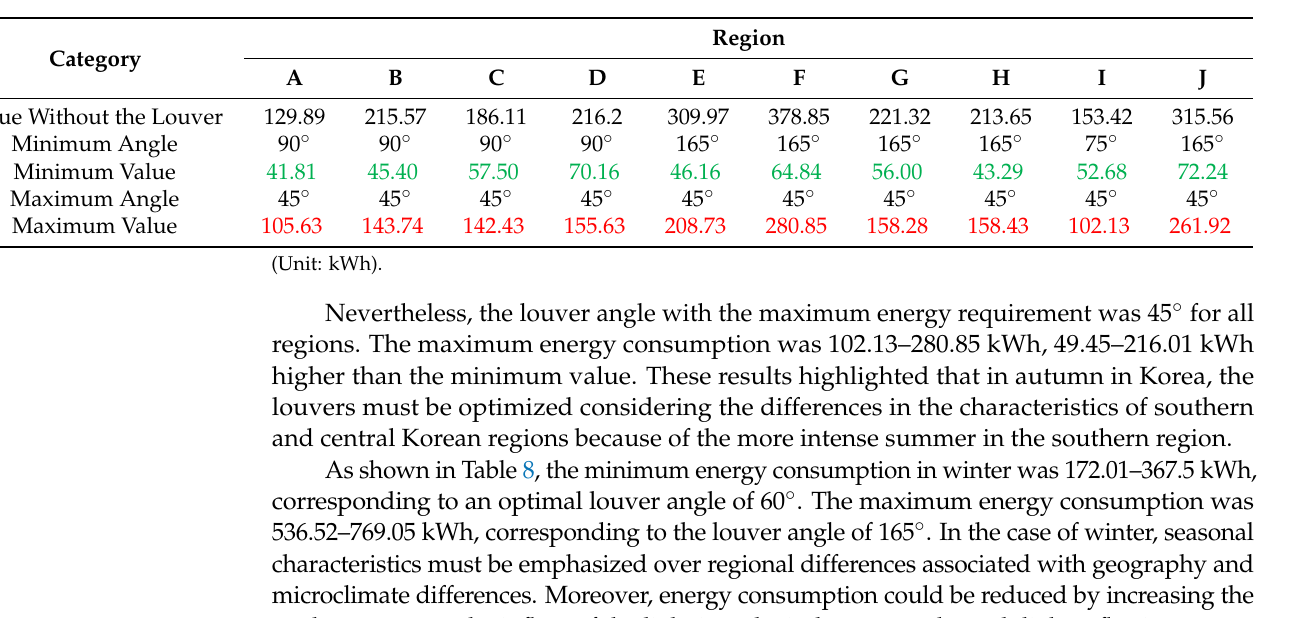
Table 7. Total thermal energy consumption in autumn.